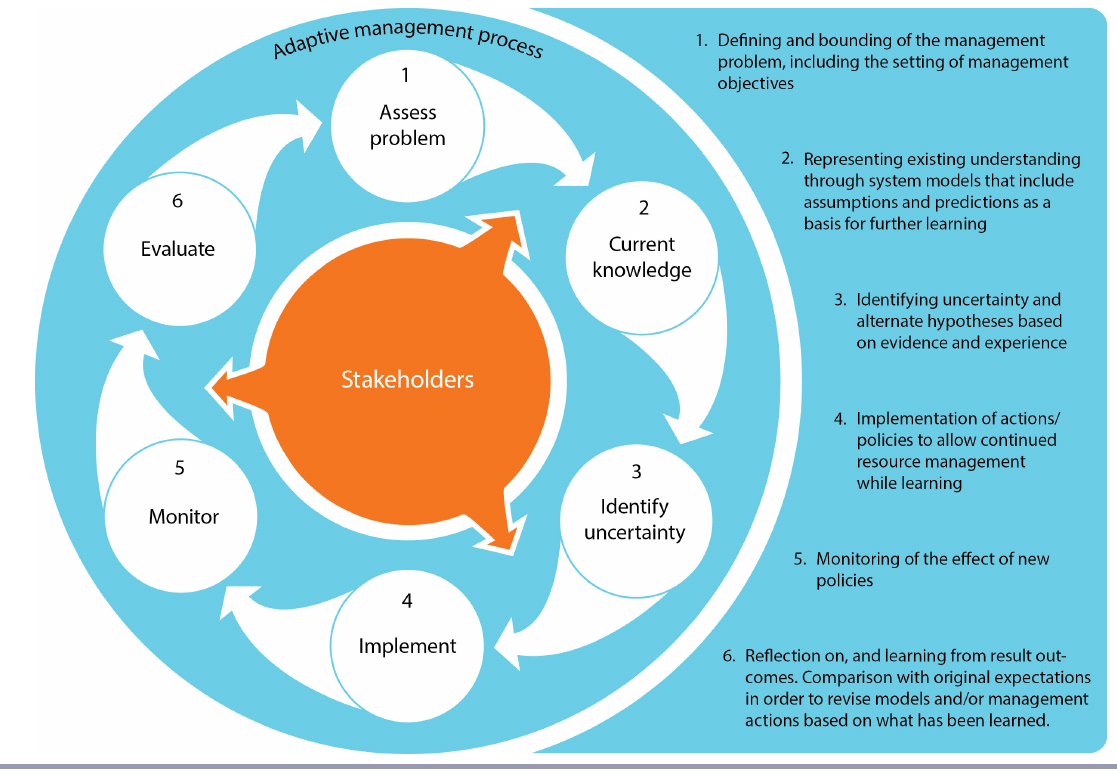
Fig. 1 . The adaptive management process (based on Walters [1986:9] and Holling [1978:20]). Stakeholder participation is considered central to the process and to achievement of successful natural resource